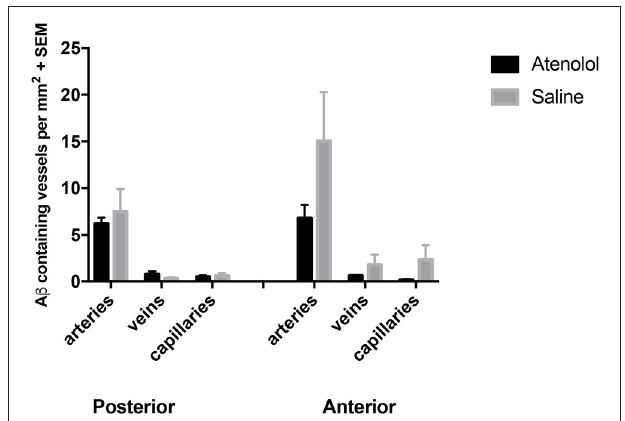
FIGURE 7 | Graphs showing the number of arteries, veins and capillaries with A β in their walls in atenolol treated mice compared to control mice. SEM: standard error of